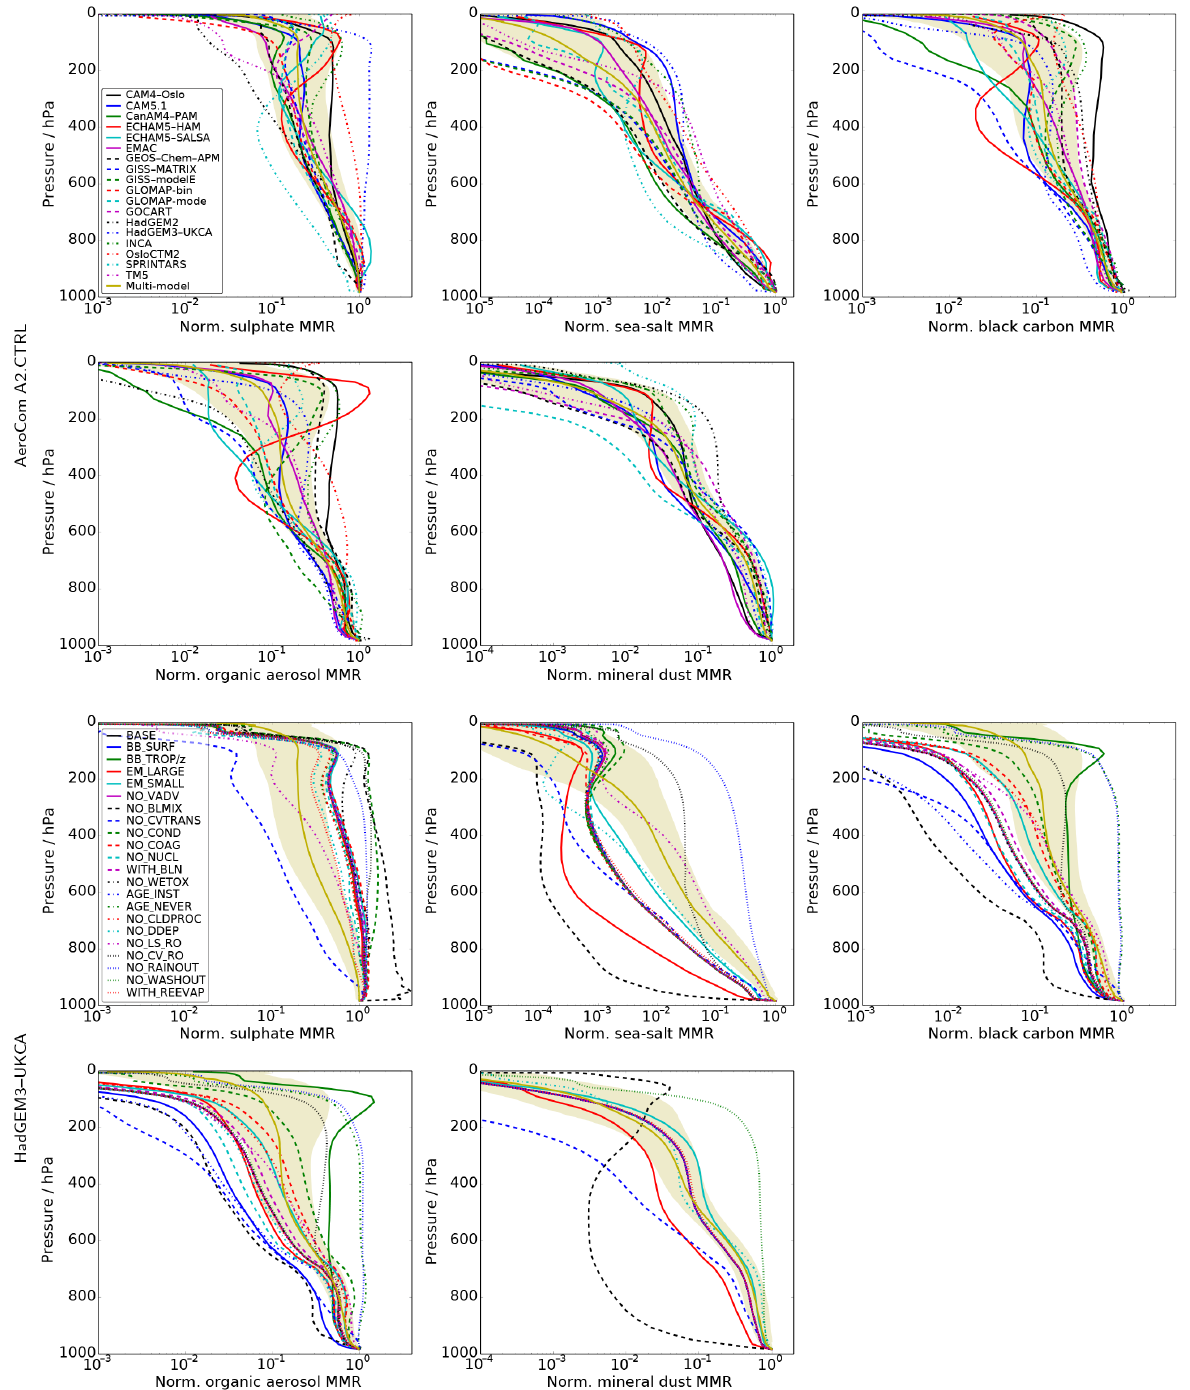
Figure 1. Annual- and global-mean vertical profiles of sulfate, sea salt, black carbon, organic aerosol and mineral dust mass mixing ratio from the AeroCom Phase II models (top) and HadGEM3–UKCA sensitivity-test simulations (bottom), normalised to the value at the surface. The multi-model geometric mean and standard deviation of the former are indicated by the yellow line and